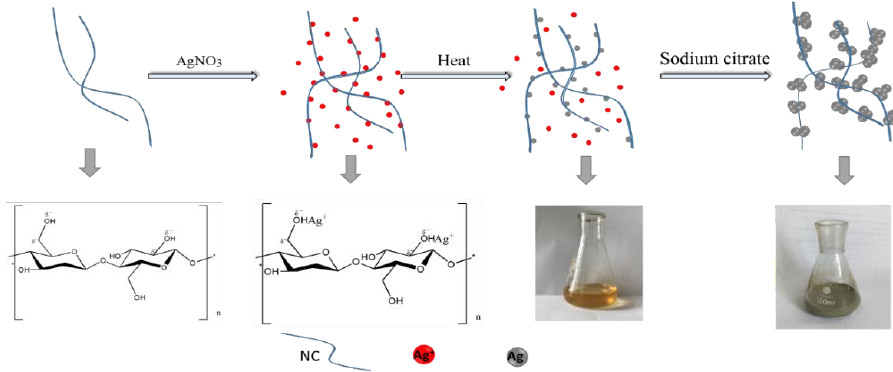
Figure 1. Mechanism and process for the fabrication of the substrate consisting of NCF-Ag.